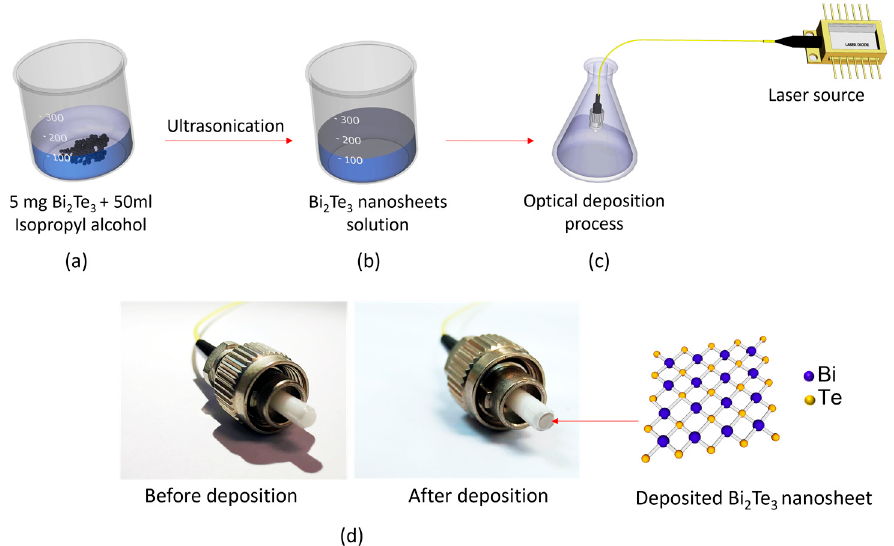
Figure 1. Preparation of Bi 2 Te 3 SA: ( a ) Bi 2 Te 3 nanosheets solution before ultrasonic bath; ( b ) Bi 2 Te 3 nanosheets solution after ultrasonic bath treatment; ( c ) optical deposition technique to append Bi 2 Te 3 at the of fiber ferrule; and ( d ) actual image of before and after Bi 2 Te 3 deposition on fiber ferrule tip.